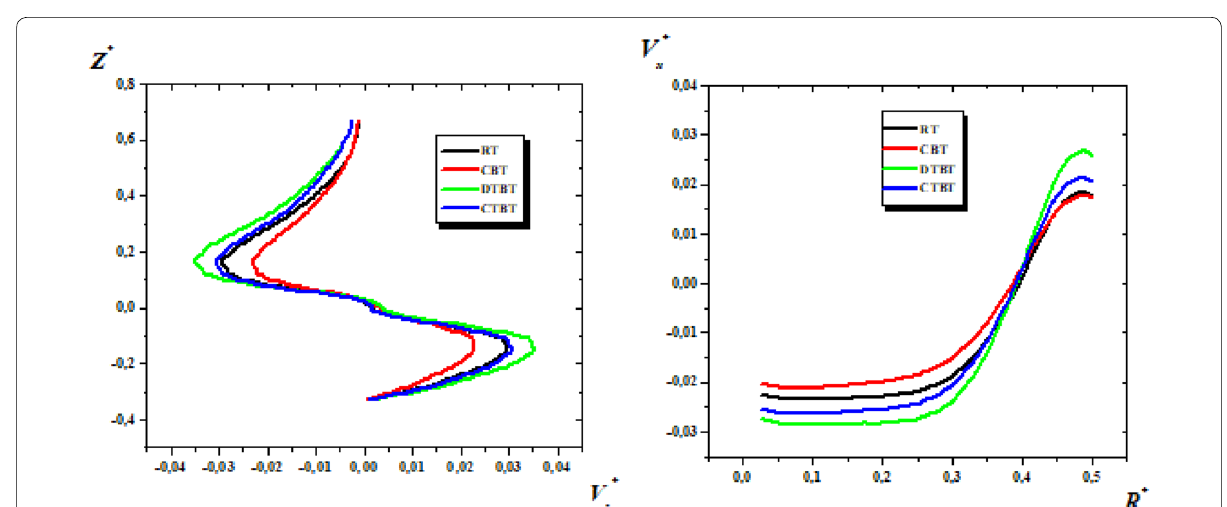
Figure 7 Velocities for different agitator’s types of baffled tanks, R *